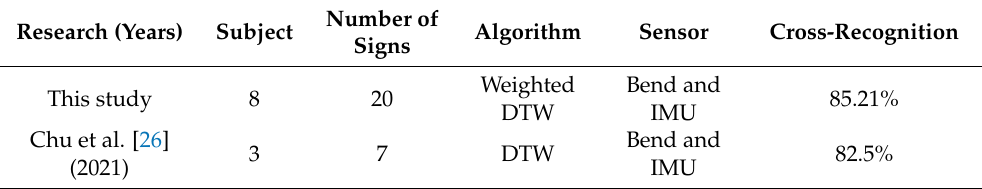
Table 3. Our system compared with Chu’s